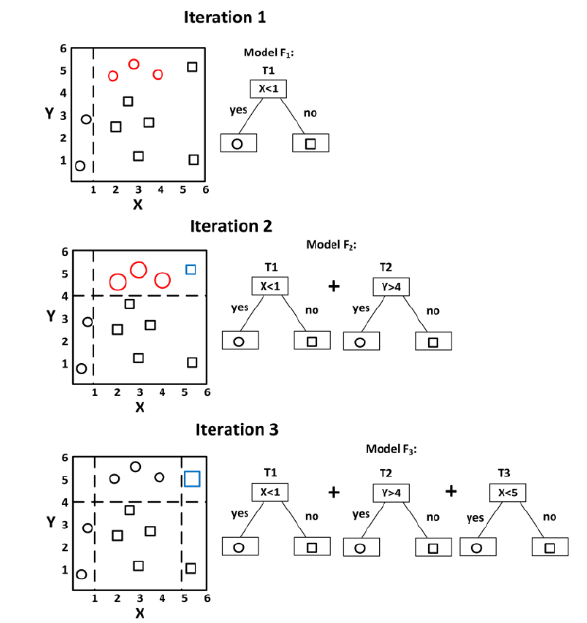
Figure 1. Functionality of Gradient boosting. © Zhang et al.